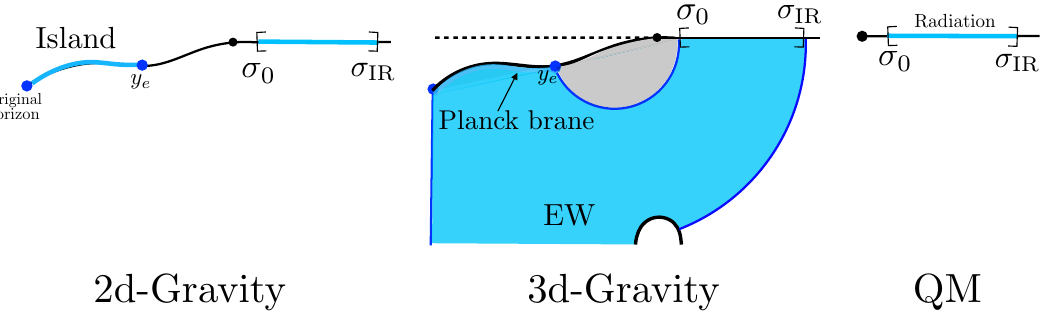
Figure 10 . An improved version of (cid:12)gure 6 showing the entanglement wedge of the radiation including a contribution from the initial black hole horizon, and a contribution from the IR cuto(cid:11) in the CFT. Both these contributions are smaller than S i Bek